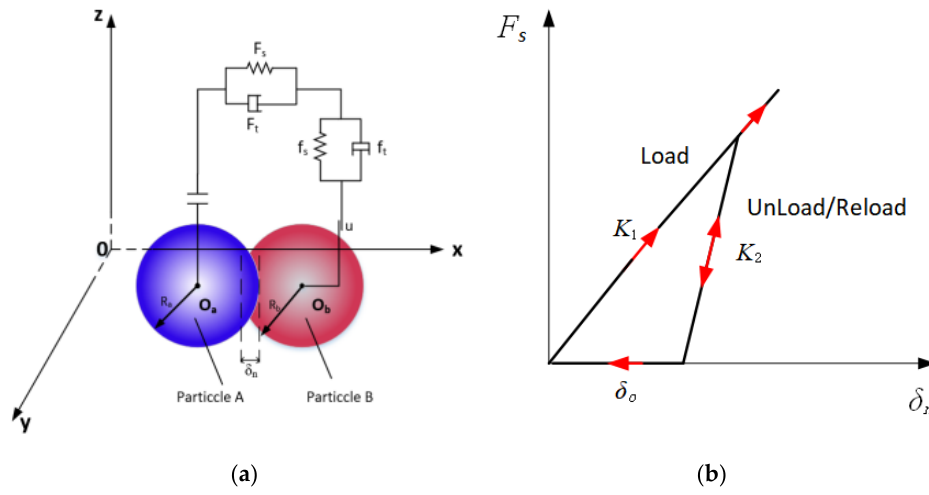
Figure 6. HSCM Contact Model. ( a ) Particle–contact relationship; ( b ) Force–displacement relationship. Note: O a and O b are the spherical center positions of two particles; R a and R b are the radii of two particles, mm; δ n is the normal overlap of particle collision, mm; δ 0 is the residual overlap between particles, mm; F s and F t are the normal contact force and damping force, N ; f s and f t are the tangential contact force and damping force, N ; μ is the friction coefficient.